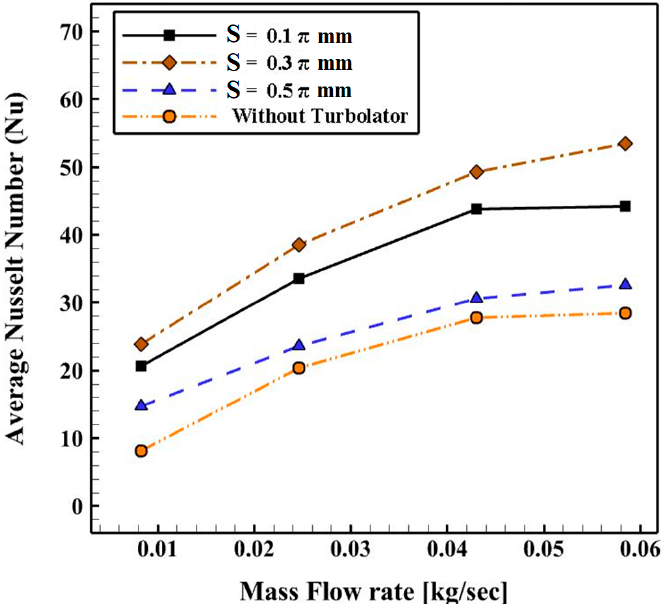
Figure 14. The deviations of average Nusselt number versus mass flow rates for various positions of the proposed swirl generator at θ = 180 degrees, n = 12, R 0 = 19 mm, r = 8.4 mm, L 1 = 100 mm, and m (cid:4662) = 0.043 kg/s. m = 0.043 kg/s.